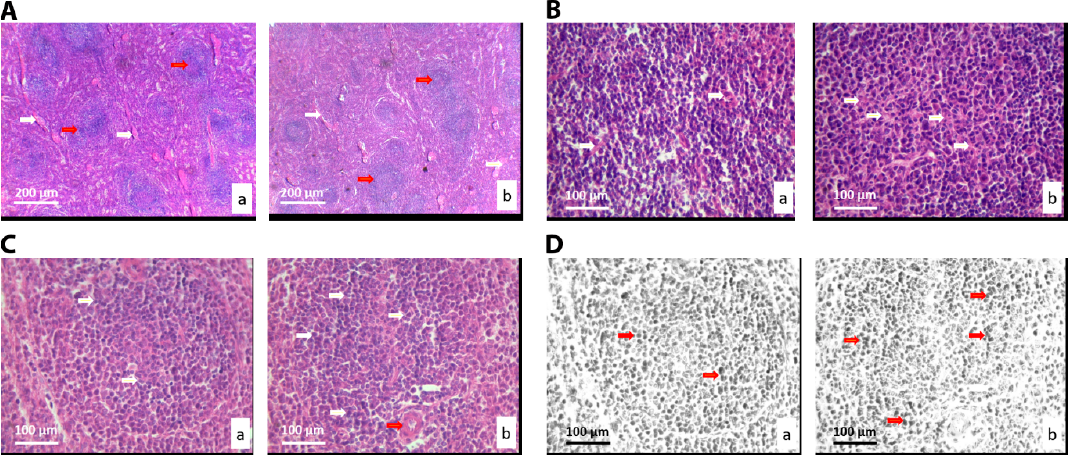
Table 5. Stereological parameters of the spleen of the control group and treated group; values are shown as mean ± SD (* p < 0.05; t- test). Figure 5. Micrographs of the histological cross-section of the rat spleen of the control (a) and treated group (b), (H&E). ( A) . White arrows show connective tissue and red arrows show lymphatic tissue. Magnification 200×; ( B ). White arrows show epithelial cells. Magnification 50×; ( C ). White arrows show lymphocytes and red arrows show blood vessel. Magnification 50× and, ( D ). Red arrows show lymphocytes. Magnification 50×; digitally processed RGB technique.